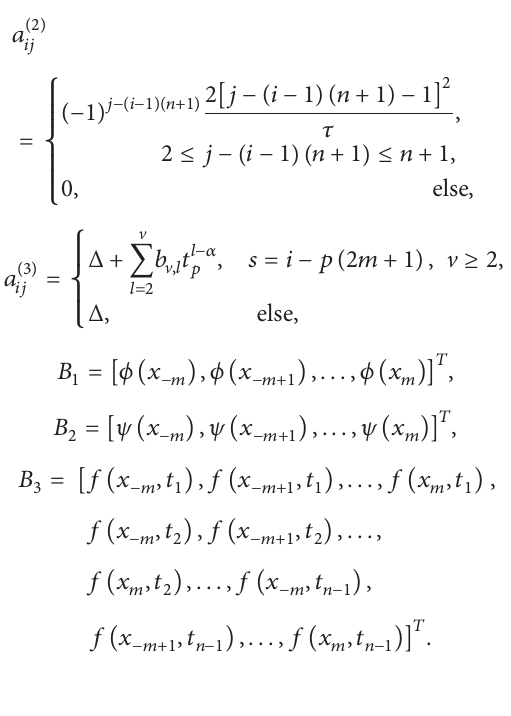
Figure 2: Plot of the absolute